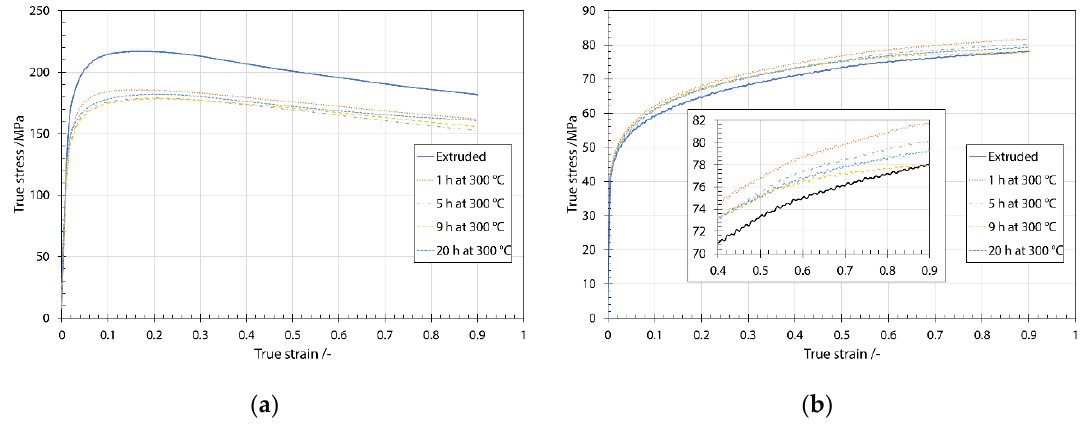
Figure 10. Influence of annealing time, at a temperature of 300 °C, on flow curves from a single-hit hot-compression test, at a strain rate of 5 s − 1 : ( a ) directly extruded Al 1080 powder and ( b ) conventional directly extruded AA 1050 alloy.